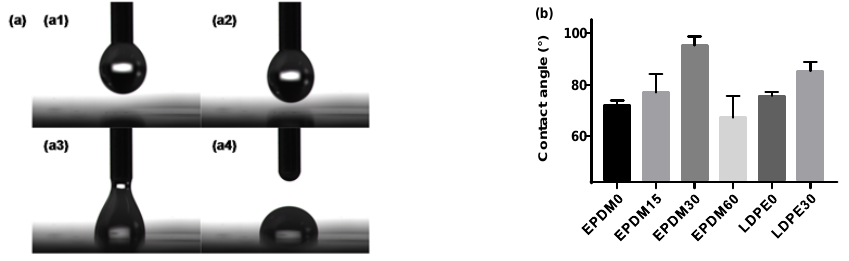
Figure 2. Hydrophobic properties of the fluorinated EPDM and LDPE. ( a ) Hydrophobicity measurement; ( b ) contact angle.